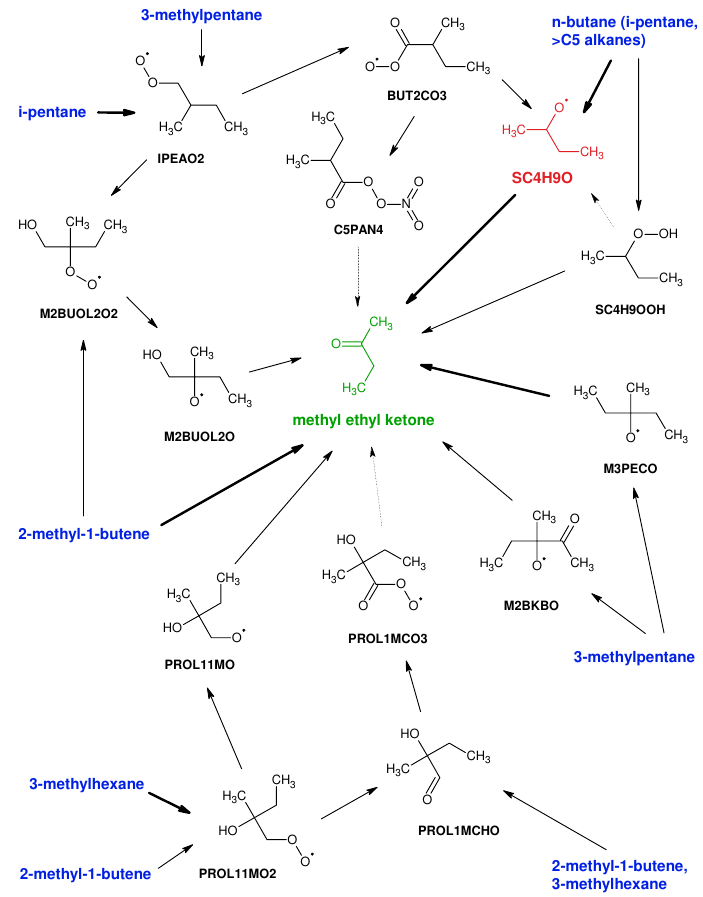
Fig. 9. Reaction scheme for the formation of MEK. Green indicates the target species, blue indicates the VOC precursors and red indicates an intermediate analyzed in detail in Sommariva et al.